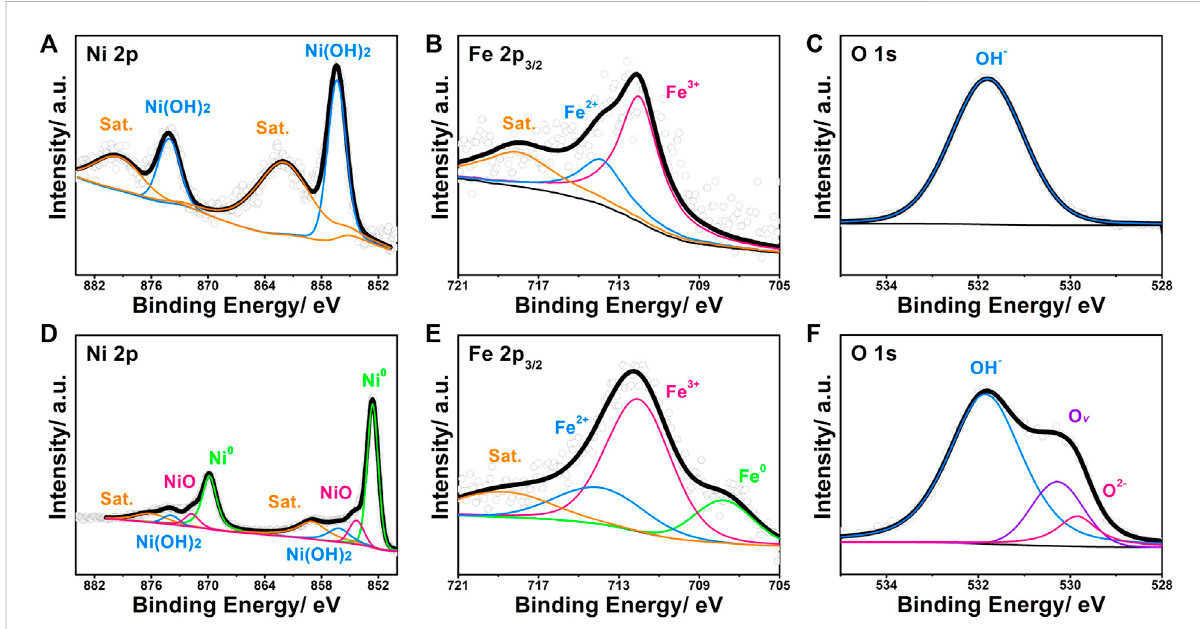
FIGURE 3 High-resolution (A) Ni2p XPSspectra, (B) Fe2p3/2 XPSspectra and (C) O1s XPSspectraofNP-NF@NFF. High-resolution (D) Ni 2pXPSspectra, (E) Fe 2p3/2 XPS spectra and (F) O 1s XPS spectra of NP-NF@NFF after